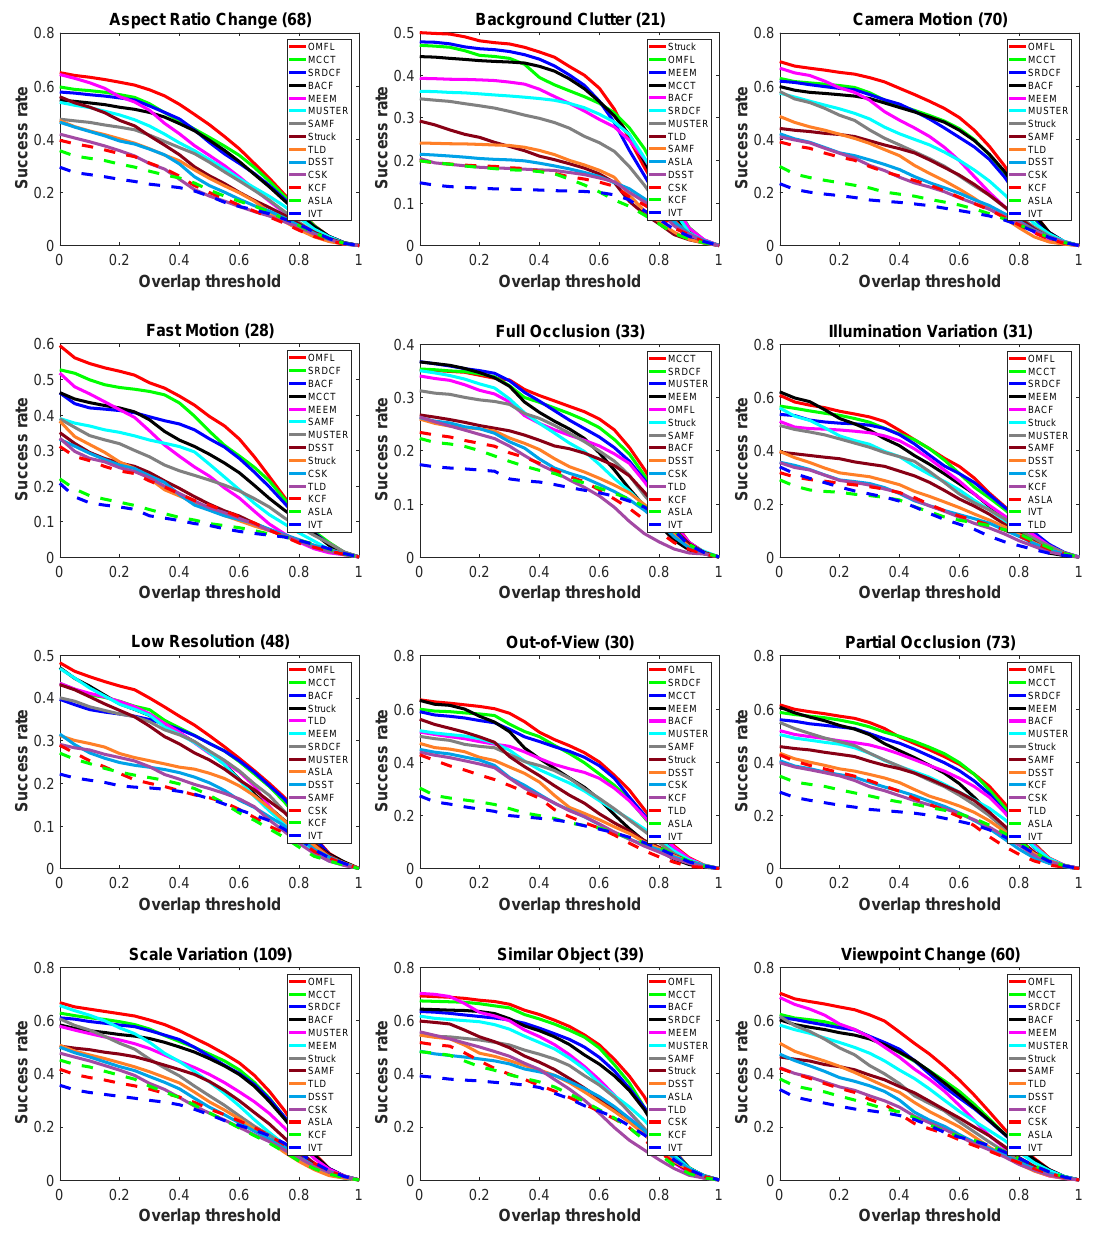
Figure 15. Success plots on different